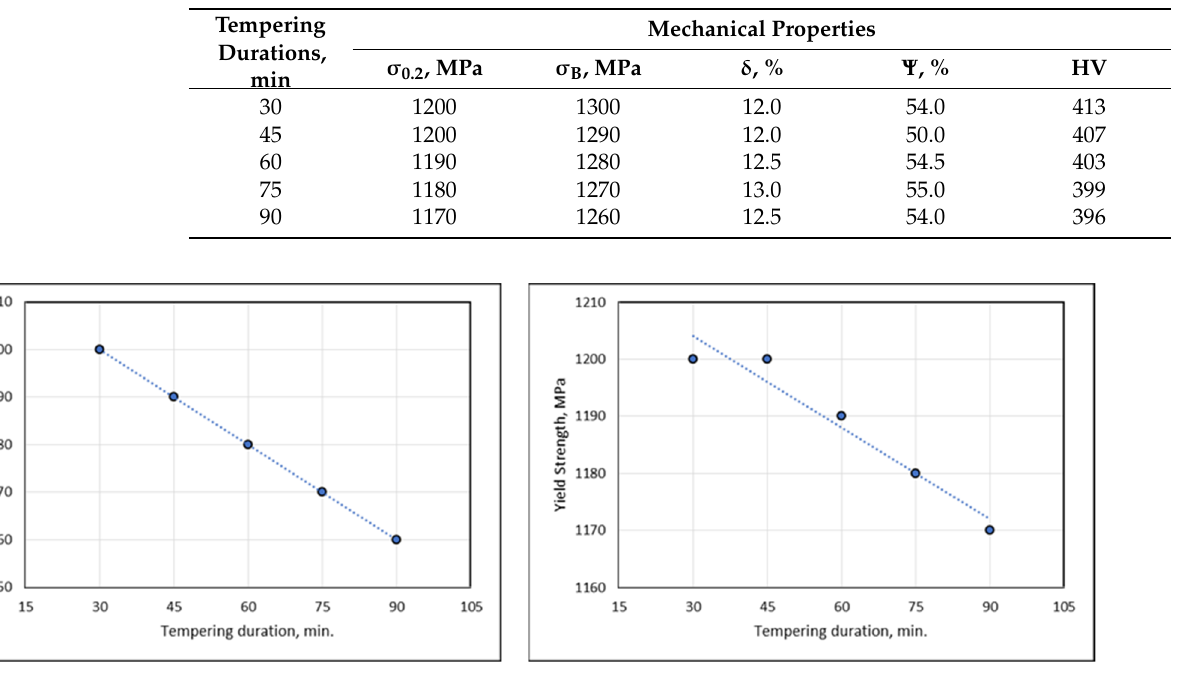
Table 4. Mechanical properties of samples of hot-rolled 42CrMo4 grade steel after quenching and tempering at 500 ◦ C after various durations.